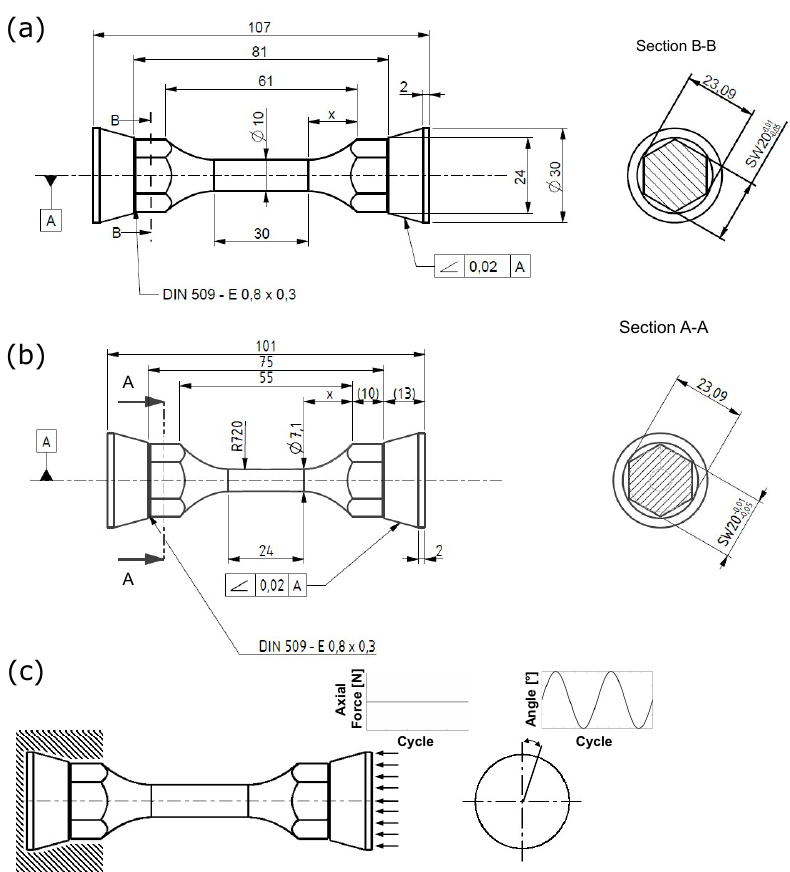
Figure 3. Figure showing the dimensions and surface finish for ( a ) HPTF specimen, ( b ) uniaxial fatigue specimen, and ( c ) HPTF loading of the specimen, indicating the constant axial force and the cyclic torsional angles.